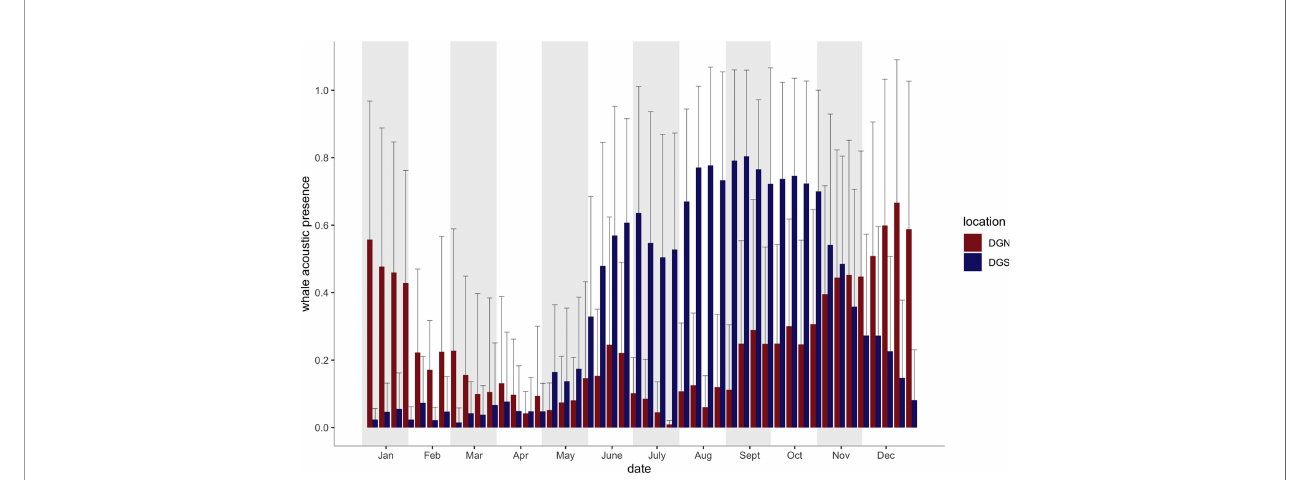
FIGURE 3 | Mean Chagos whale acoustic presence (%) + Standard error (de fi ned as the percentage of hours when whale songs were detected, see Material and Methods ) on the DGS and DGN site for each eight-day period (46 bins for each site) during the study period (2002- 2014 on the DGN site: N = 9 years for 2 of the